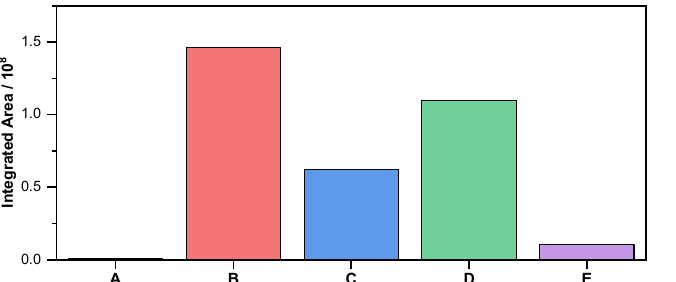
Figure 3. Integrated areas from GCMS peaks for n -dodecane extracted (SPME) from: ( A ) 3.7 ppm dodecane in water; ( B ) original PE in water, ~0.5 MGy; ( C ) original PE in water, ~2 MGy; ( D ) original PE in saltwater, ~0.5 MGy; ( E ) original PE in water, no irradiation. The vertical axis represents 10 9 integration values.